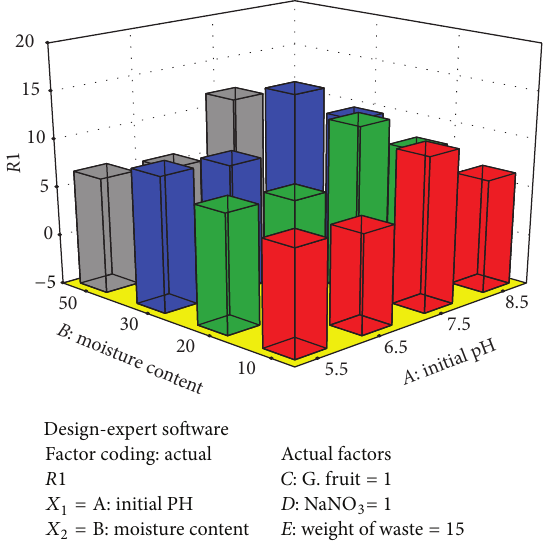
Figure 4: 3D surface plot showing the effect of initial pH and moisture content on naringinase activity.